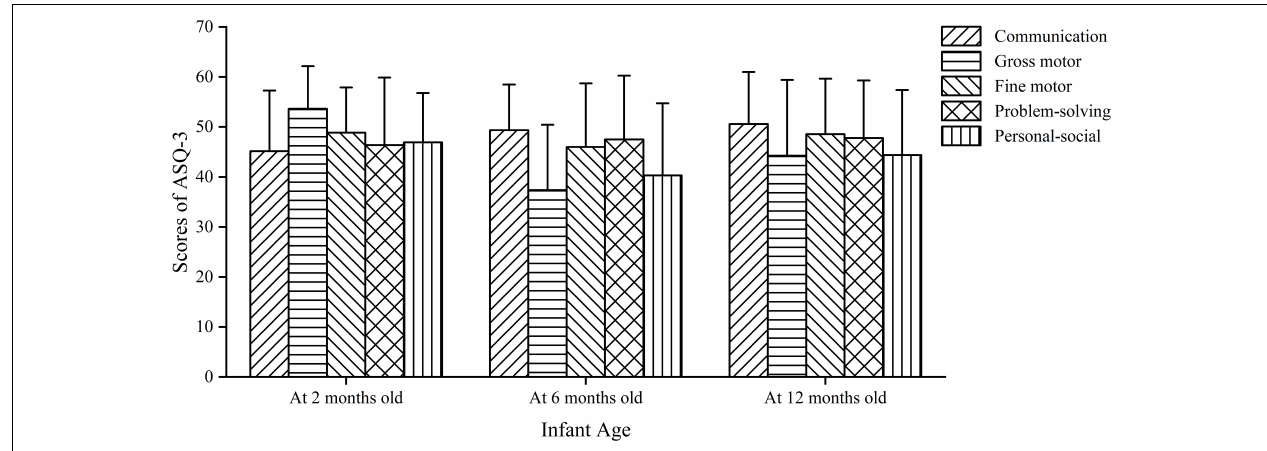
FIGURE 1 | Distribution of scores of developmental domains of ASQ-3 for infants at 2, 6, and 12 months of age.